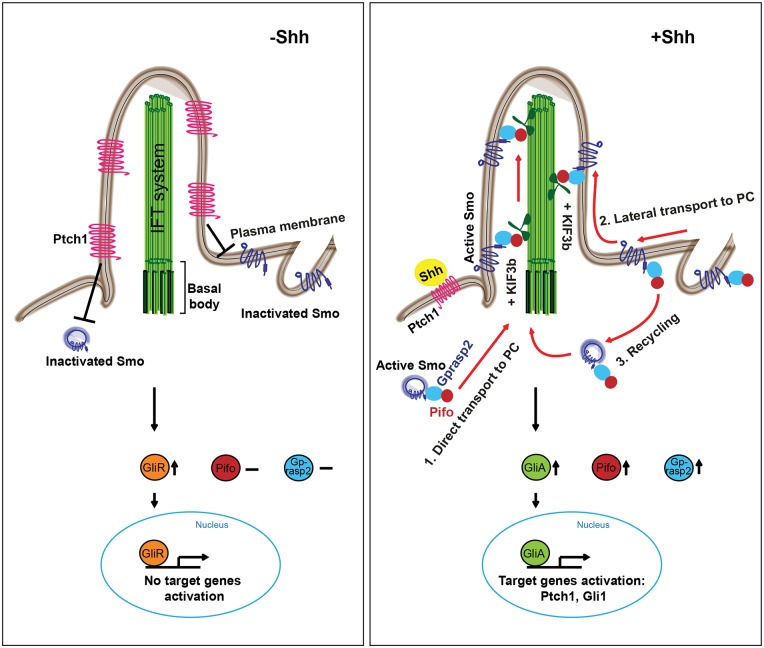
Hypothetical model of Smo transport and regulation by Pifo and Gprasp2 upon Shh signaling.In the absence of Shh signaling (left), Ptch1 localizes to the PC and suppresses Smo translocation to PC. The proteolytically processed repressor forms of Gli (GliR) accumulate and enter the nucleus to inhibit target gene expression. In the presence of Shh (right), Pifo and Gprasp2 rapidly form a Smo ciliary targeting complex. This can be transported to the PC from 1. intracellular pools or 2. via lateral plasma membrane transport or 3. via the recycling endosome pathway. Smo transport into the PC is mediated through the kinesine II motor complex leading to accumulation of Gli activator forms (GliA) in the cytoplasm and nucleus for Shh target gene activation.